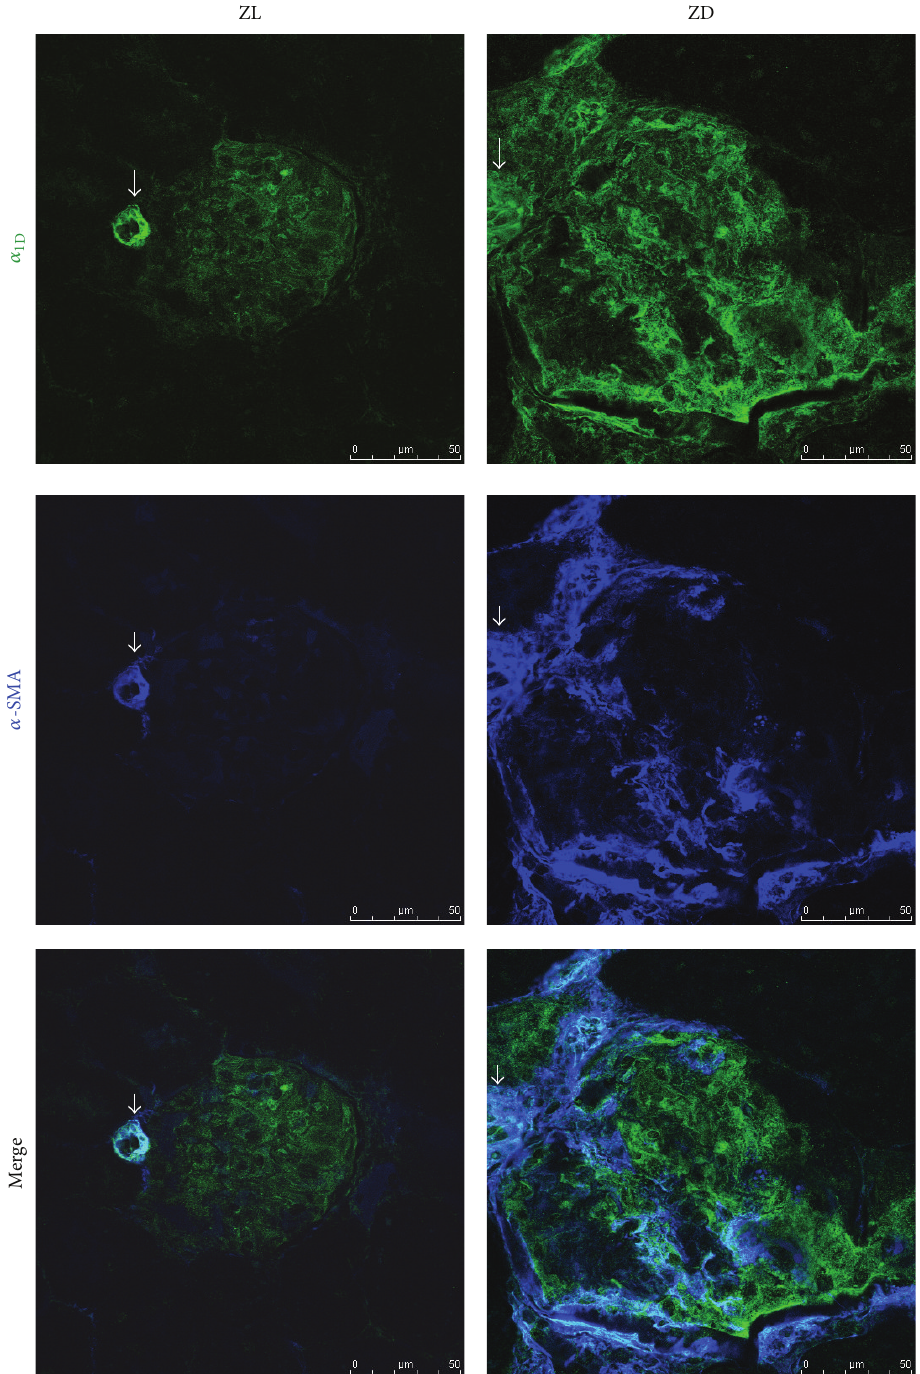
Figure 4: Representative confocal immunofluorescence images of 𝛼 1 -AR and 𝛼 -smooth muscle actin ( 𝛼 -SMA) in the glomeruli of ZL and D -AR (green) with 𝛼 -SMA (dark blue) was apparent in the renal vasculature (white arrow), ZD rats. In normal control, colocalization of 𝛼 1 D -AR was detected in the glomeruli. An increase in 𝛼 1 -AR staining in the diabetic glomeruli was accompanied whereas weak staining of 𝛼 1 D D by an increase in 𝛼 -SMA